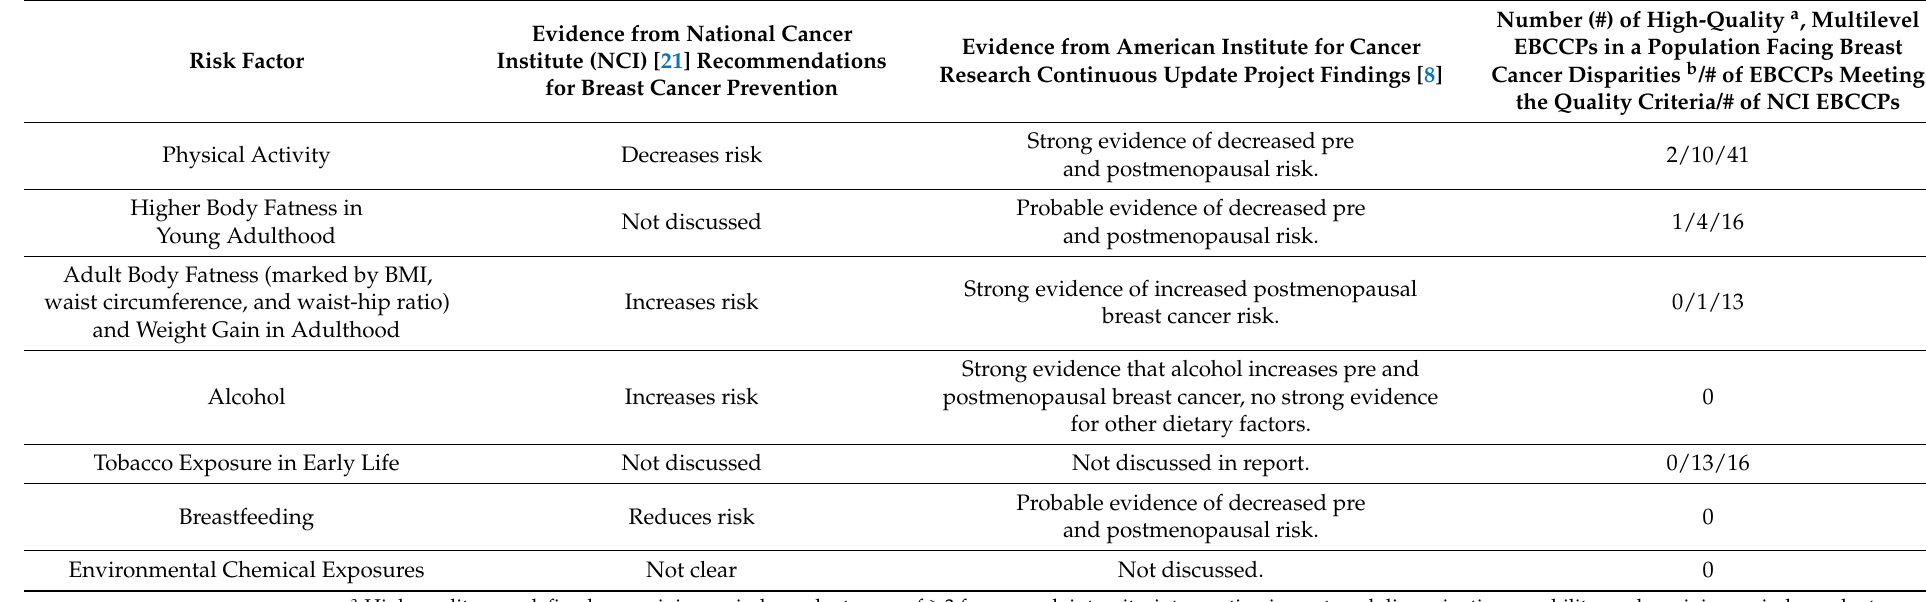
Table 1. Summary of breast cancer risk reduction categories